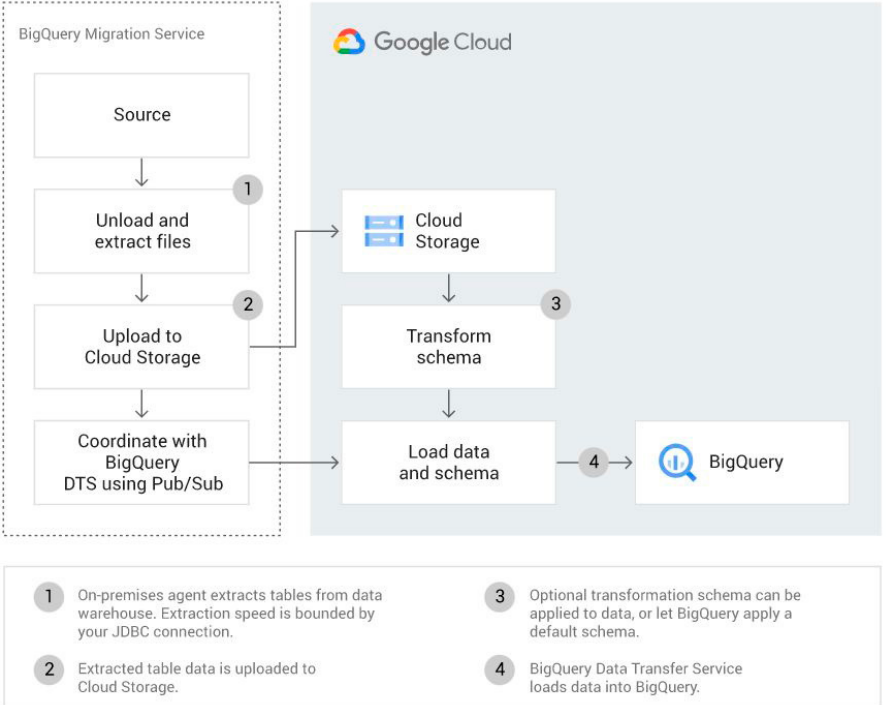
Figure 3. Data flow between an on-premises data warehouse like Google BigQuery. This process is followed for storage of structured data.